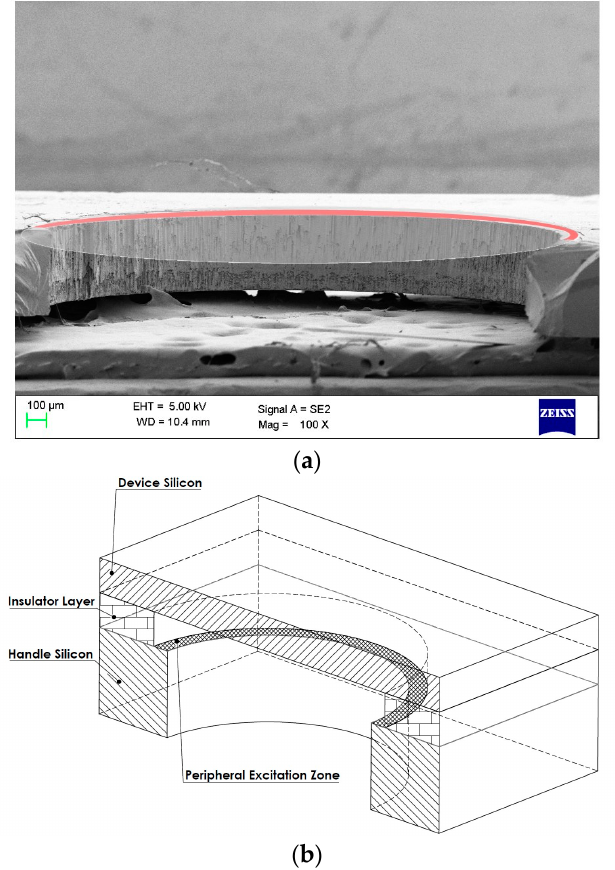
Figure 2. The figure ( a ) shows an SEM image of the device cross-section where the suspended diaphragm is removed for clear view of the structure, showing position of peripheral actuation (red) highlighted, along with schematic of the suspended diaphragm, figure ( b ) shows a schematic of the device cross-section highlighting the peripheSral region for electrostatic